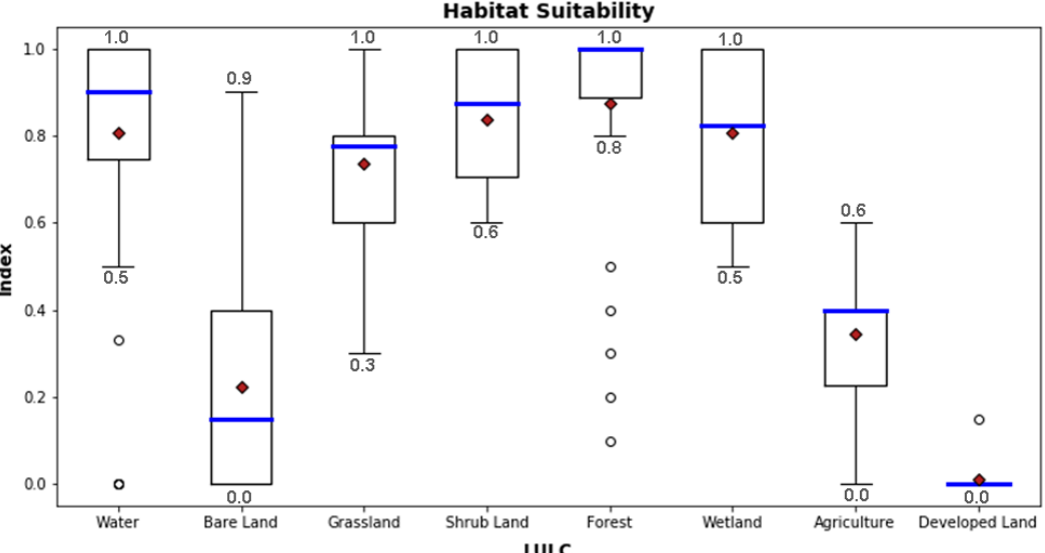
Figure 3. The suitability box plots for each LULC class. The whiskers indicate 1.5 times the interquartile range values. The bold line represents the median and the diamond shaped markers represent the mean. The circles are the outliers.